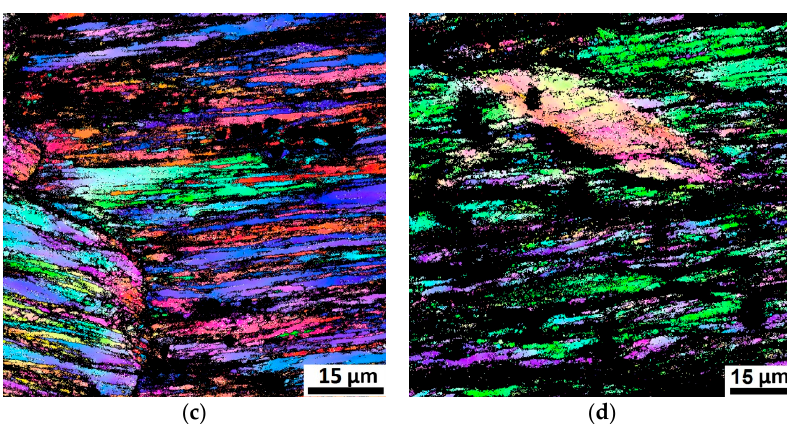
Figure 2. EBSD IPF maps of the Al-, C-containing CoCrFeNiMn-type alloy after cold rolling with different thickness reduction: ( a ) 20%; ( b ) 40%; ( c ) 60%; and ( d ) 80%. Rolling direction is aligned with the horizontal axis.